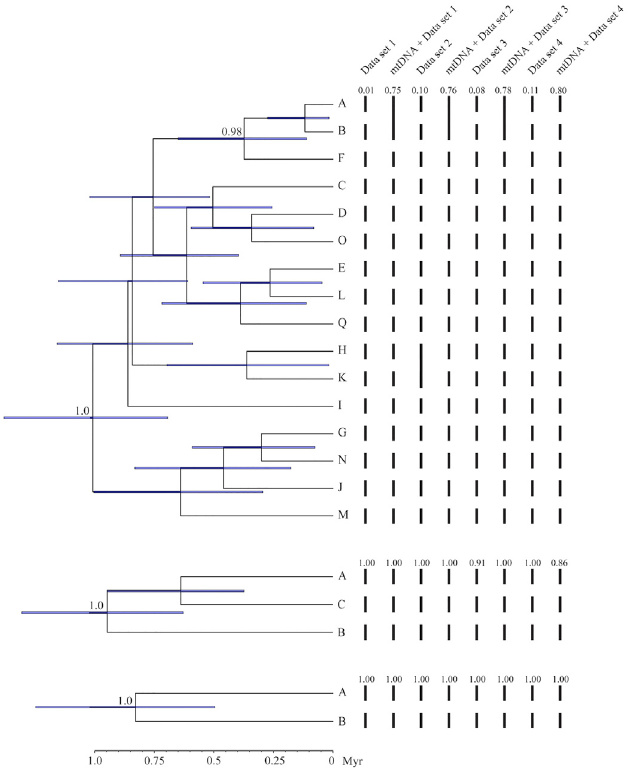
Fig 7. Maximum clade credibility trees from * BEAST 2, with species delimitations from BPP. Numbers at tree nodes are posterior probabilities; numbers < 0.95 have been omitted. Bars at nodes represent the 95% highest posterior density for the inferred ages of nodes. To the right, bars connect putative species that were combined in the BPP analyses. (A) 16 species as delimited by bGMYC, using mtDNA data; (B) 3 species as delimited by Geneland, using the nuclear data; (4) 2 species as delimited by bGMYC, using mtDNA data. See also Fig 3 for species delimitations.